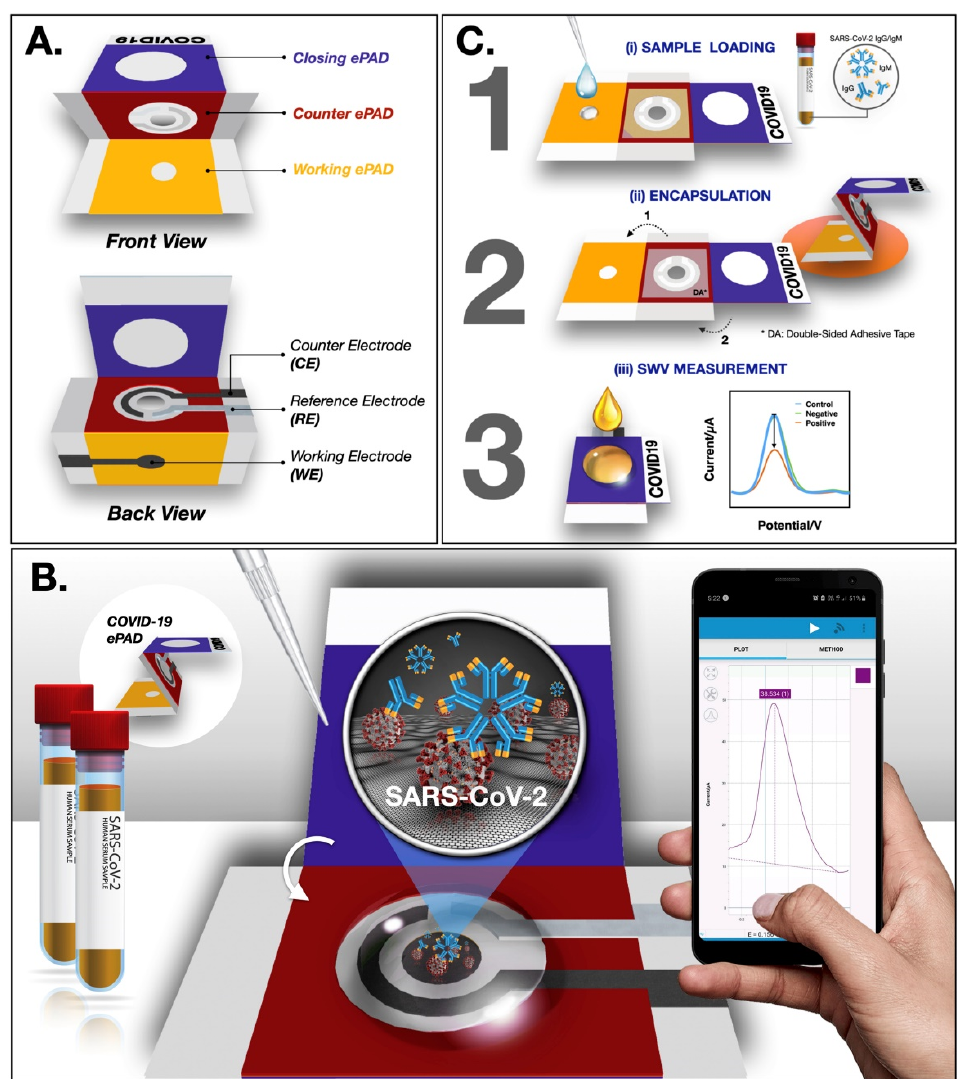
Figure 11. ( a ) Various components of a COVID-19 ePAD; SARS-CoV-2 antibody detection principle Figure 11. ( A ) Various components of a COVID-19 ePAD; SARS-CoV-2 antibody detection ( b ); and detection procedure ( c ). Reprinted with permission from Elsevier B.V. [57], Copyright principle ( B ); and detection procedure ( C ). Reprinted with permission from Elsevier B.V. [57], Copy- (2020). right